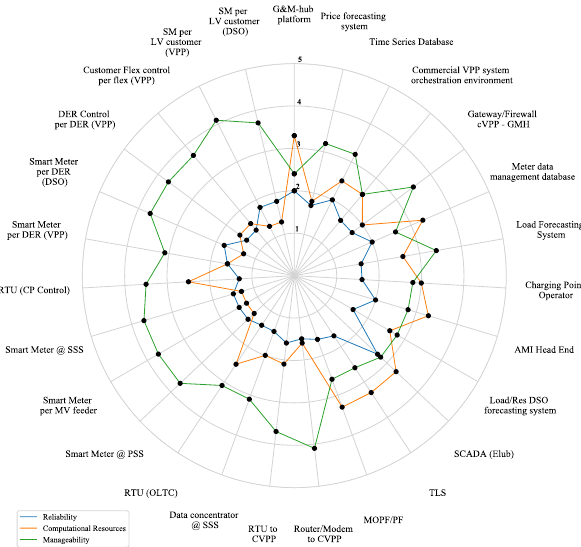
Figure 3. Attributes scores for components in the Large Customer Commercial VPP scenario, where potential critical components appear by having low scores in the different categories.